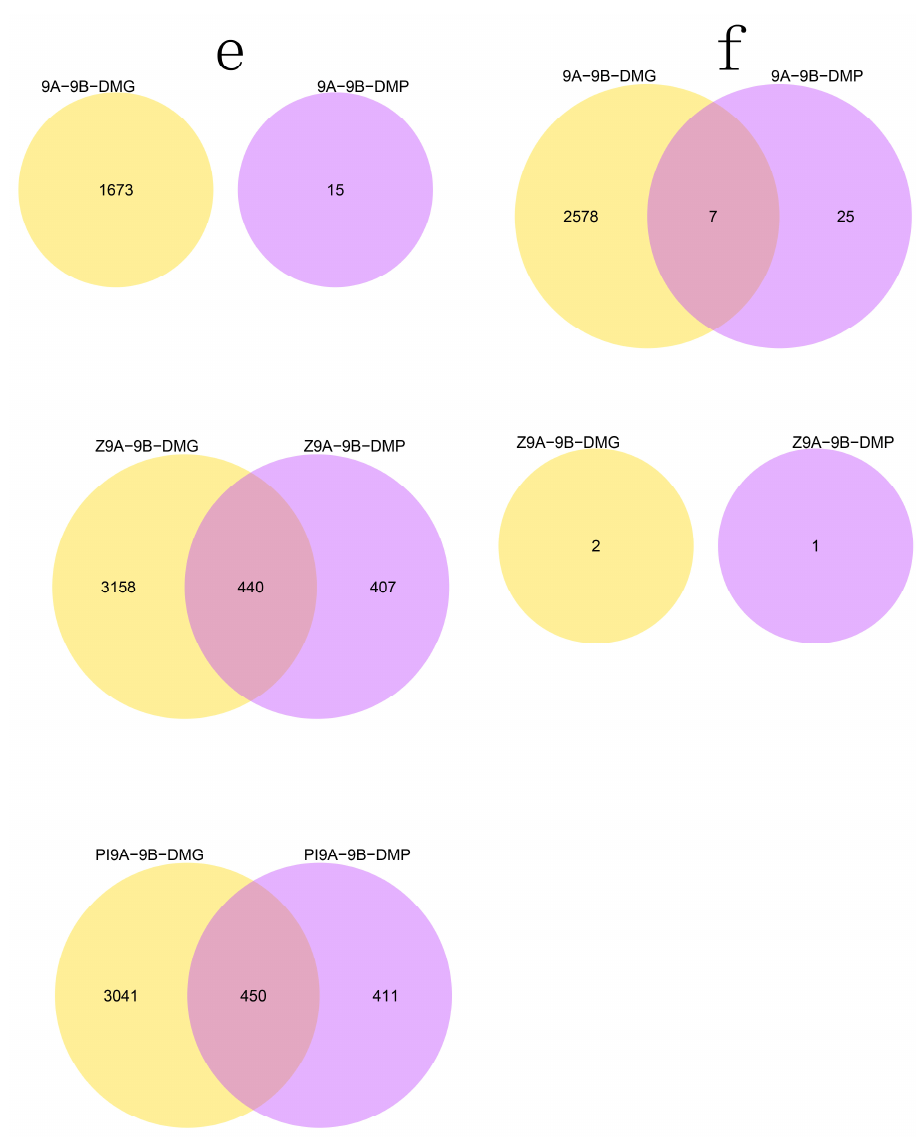
Figure 5. Venn diagrams of differentially methylated genes (DMGs) and differentially methylated promoters (DMPs) in the three sequence contexts of differentially methylated regions (DMRs) in the soybean genome. Yellow circles indicate hypomethylation; pink circles indicate hypermethylation. ( a , c , e ) hypermethylation in sequence contexts CG, CHG, and CHH, respectively. ( b , d , f ) hypomethylation in sequence contexts CG, CHG, and CHH, respectively. 9A-9B-DMG and 9A-9B-DMP, JLCMS9A vs JLCMS9B; Z9A-9B-DMG and Z9A-9B-DMP, JLCMSZ9A vs JLCMS9B; PI9A-9B-DMG and Z9A-9B-DMP, JLCMSPI9A vs JLCMS9B; DMG, differentially methylated genes; DMP, differentially methylated promoters.